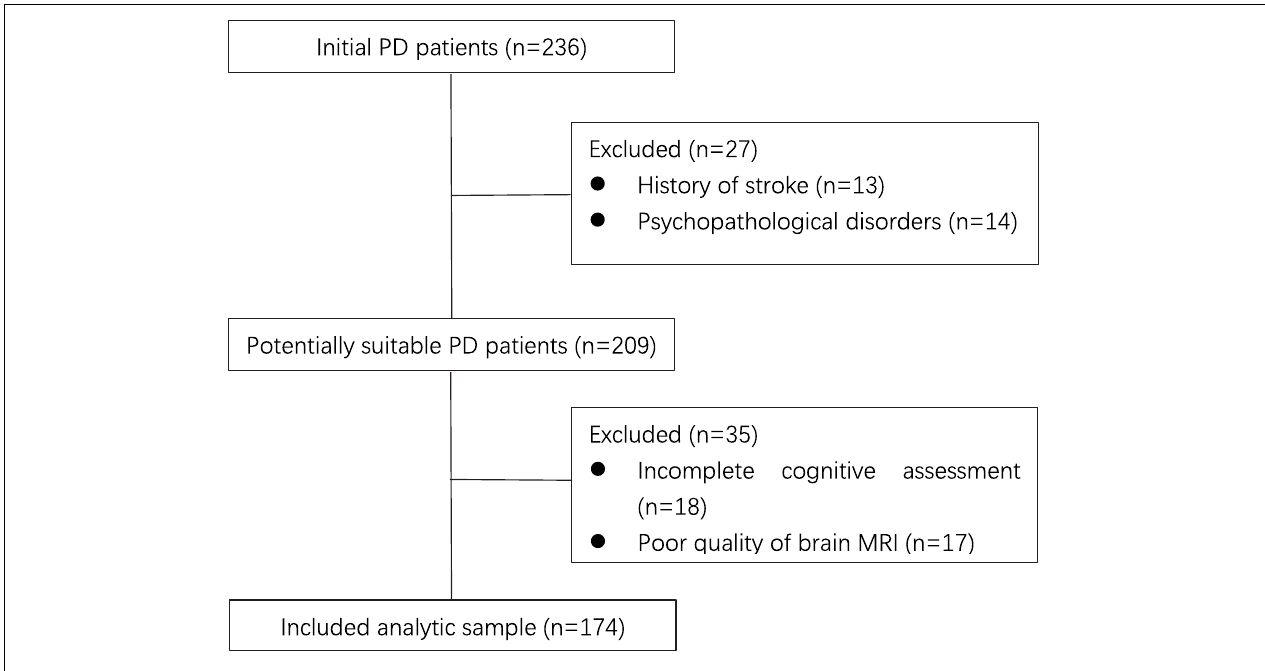
FIGURE 1 | Flowchart of patient enrollment. PD, Parkinson’s disease; MRI, magnetic resonance